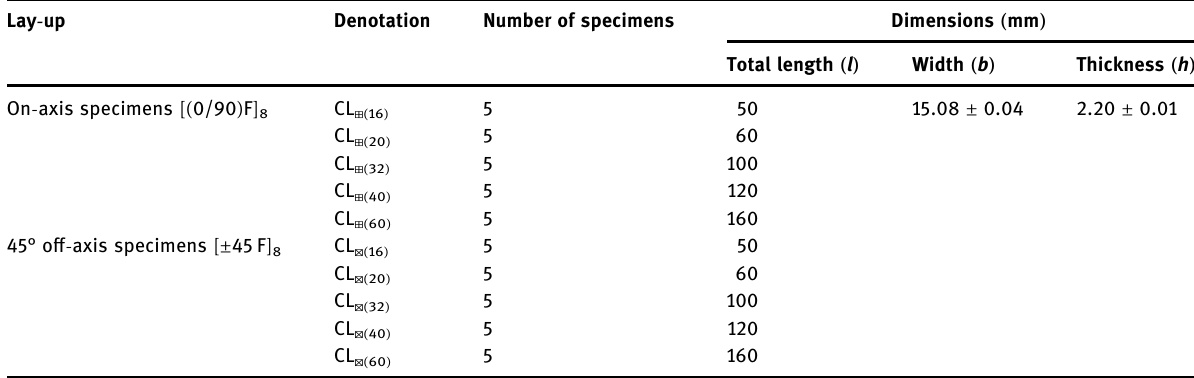
Table 1: Types and dimensions of the CL specimens Lay - up Denotation Number of